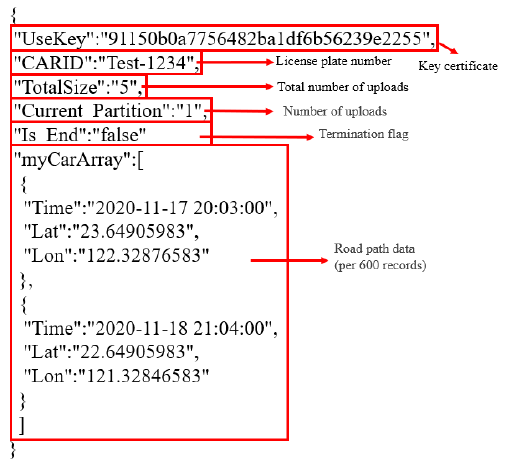
Figure 23. GPS data upload format.